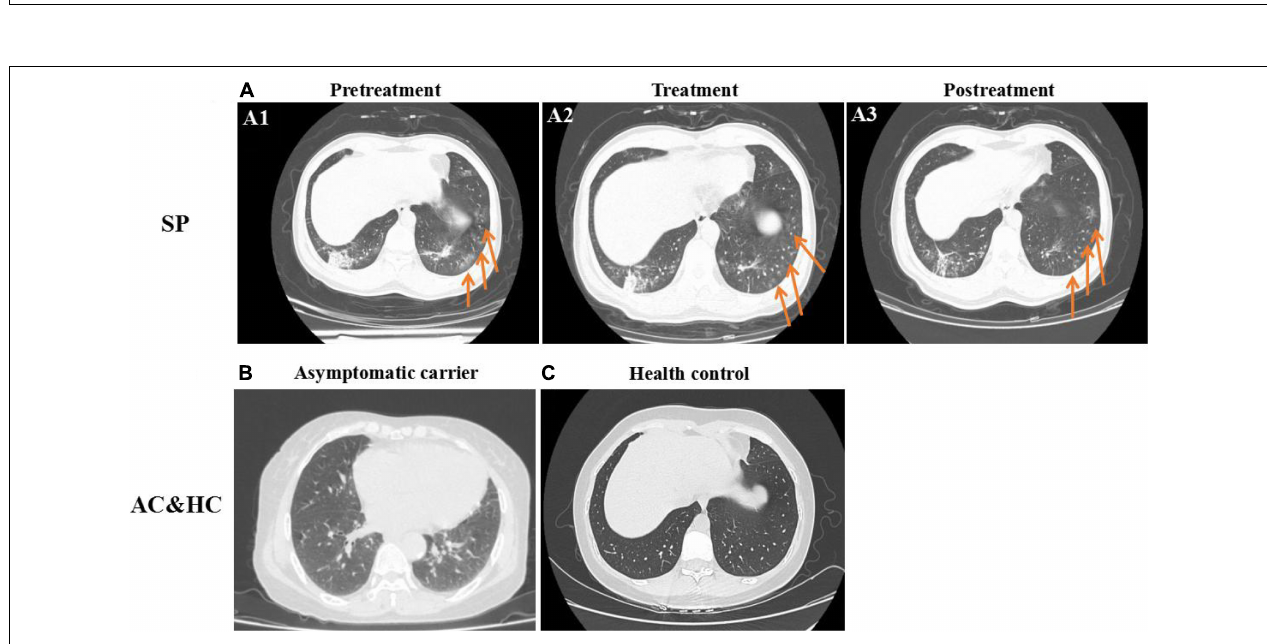
FIGURE 2 | Typical chest CT imaging in SPs, asymptomatic carriers (ACs), and healthy controls (HCs) (same abbreviations in subsequent figures). (A) CT imaging in SPs. (A1) Pretreatment. (A2) Treatment. (A3) Posttreatment. (B) CT imaging in ACs. (C) CT imaging in HCs. Bilateral pneumonia and multiple ground glass shadows were obvious in SPs and were marked with arrows (A1–A3) , whereas pulmonary lesions in ACs (B) were not obvious compared with the control (C) .